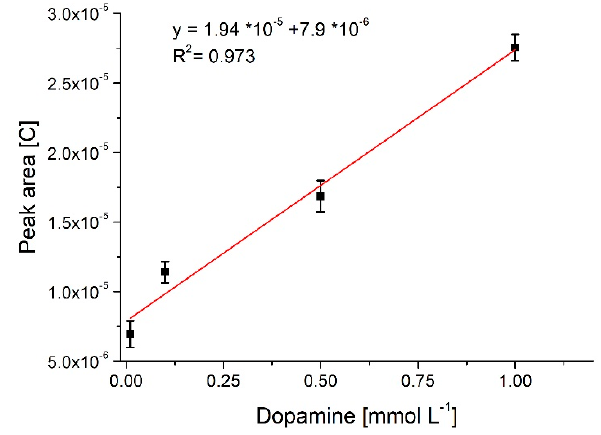
Figure 7. Calibration curve for dopamine, standard deviation calculated for n = 3. Array of 16 posts, flow of 100 µL min − 1 , pencils oxidized at constant potential in PBS.